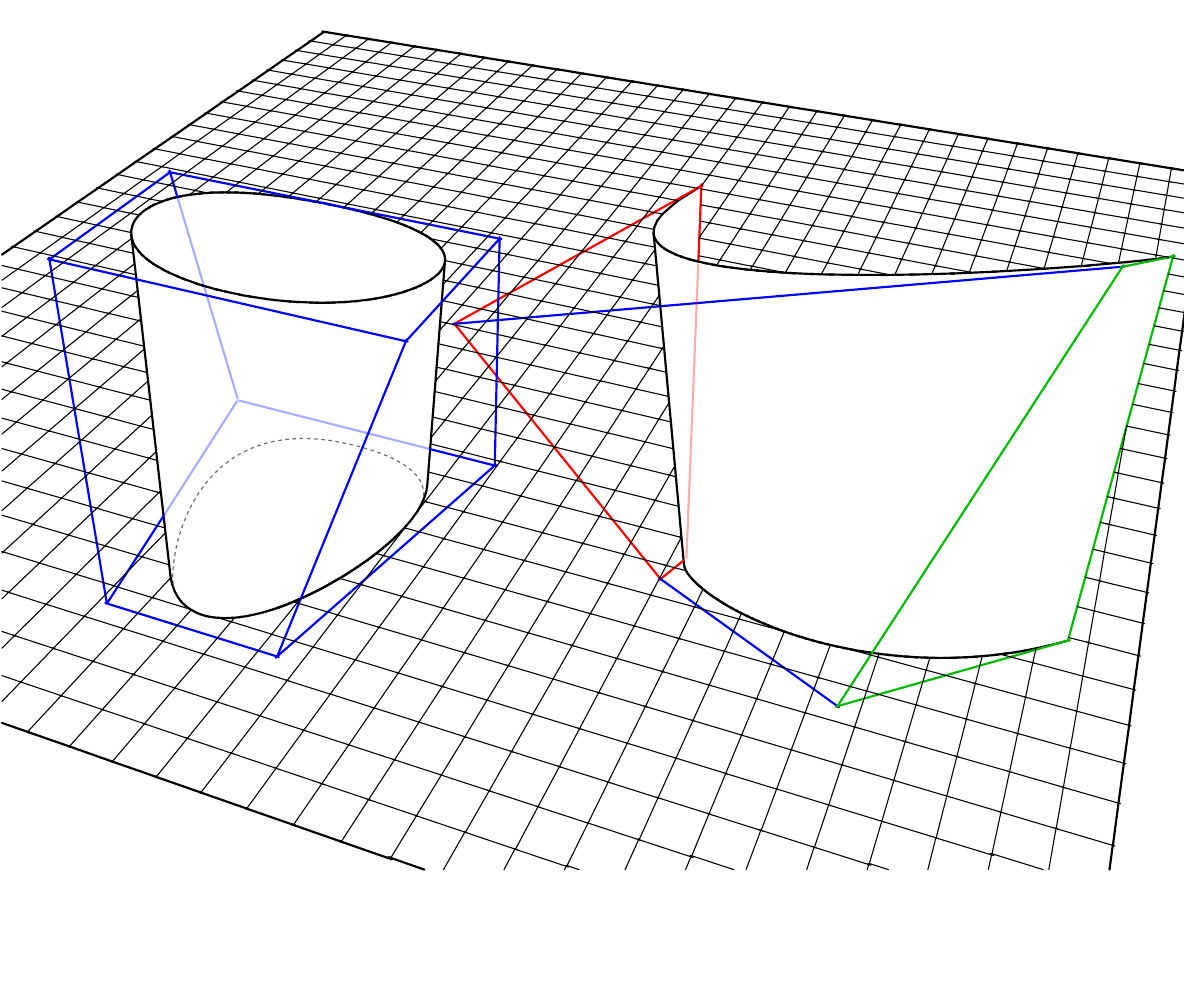
Figure 3. ‘C’ and ‘O’ shaped simple developable surfaces and their construction. The red and green quadrilaterals are each planar, however none of the blue quadrilaterals need to be planar in order to generate developable surfaces.